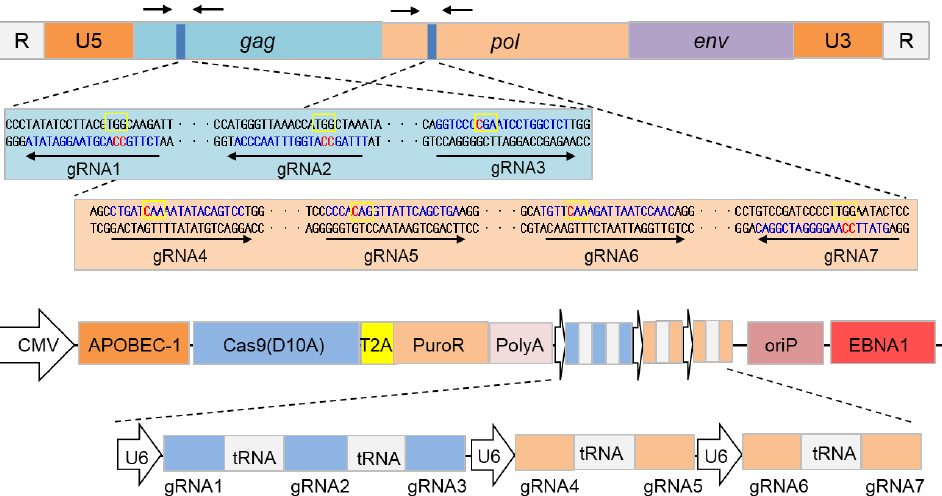
Figure 1. The design of MAIO-epiCBE system for base editing of the PERV genome. ( A ) Schematic diagram of PERV structure. ( B ) Three sgRNAs targeting the gag region. ( C ) Four sgRNAs targeting the pol region. The sgRNA target sequences are in blue. The objective C base is marked in red. The target codons are boxed in a yellow frame. ( D ) Structure of multi-target all-in-one Or-iP/EBNA1-based CBE